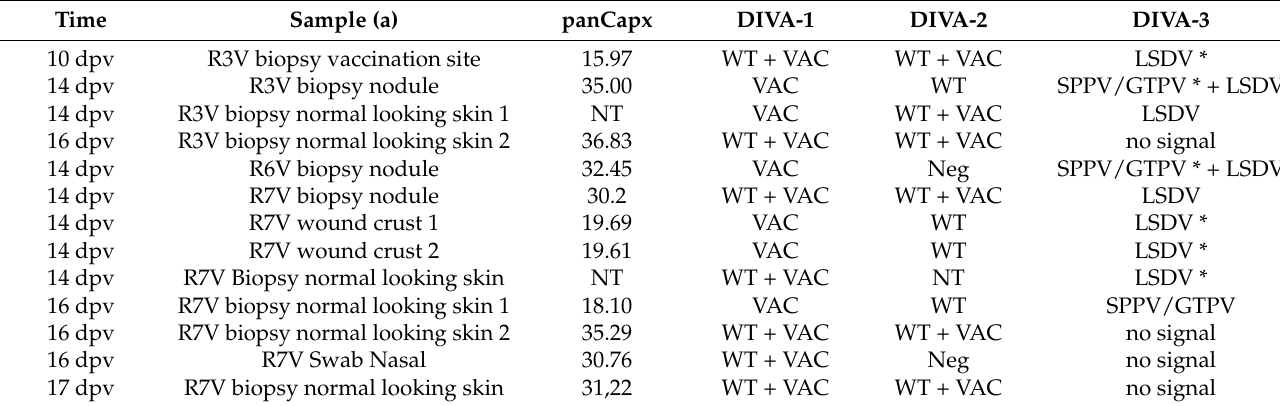
Table 1. PCR results of the biopsies, wound crusts and swab taken after vaccination. (a): All biopsies and wound crusts were collected at least 10 cm away of the vaccination site, except the biopsy of the vaccination site itself; NT: not tested; WT: wild type LSDV signal; VAC: vaccine type LSDV signal; WT + VAC: a wild type and vaccine type LSDV signal; *: was excised for direct